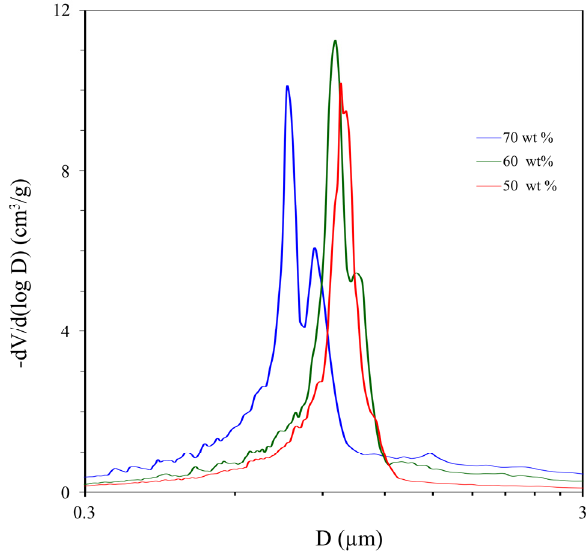
Figure 7. The pore size distribution of poly-OCM-2 ( М 12- М 14) obtained from OCM-2 in the pres- ence of 1-butanol (50–70 wt %).